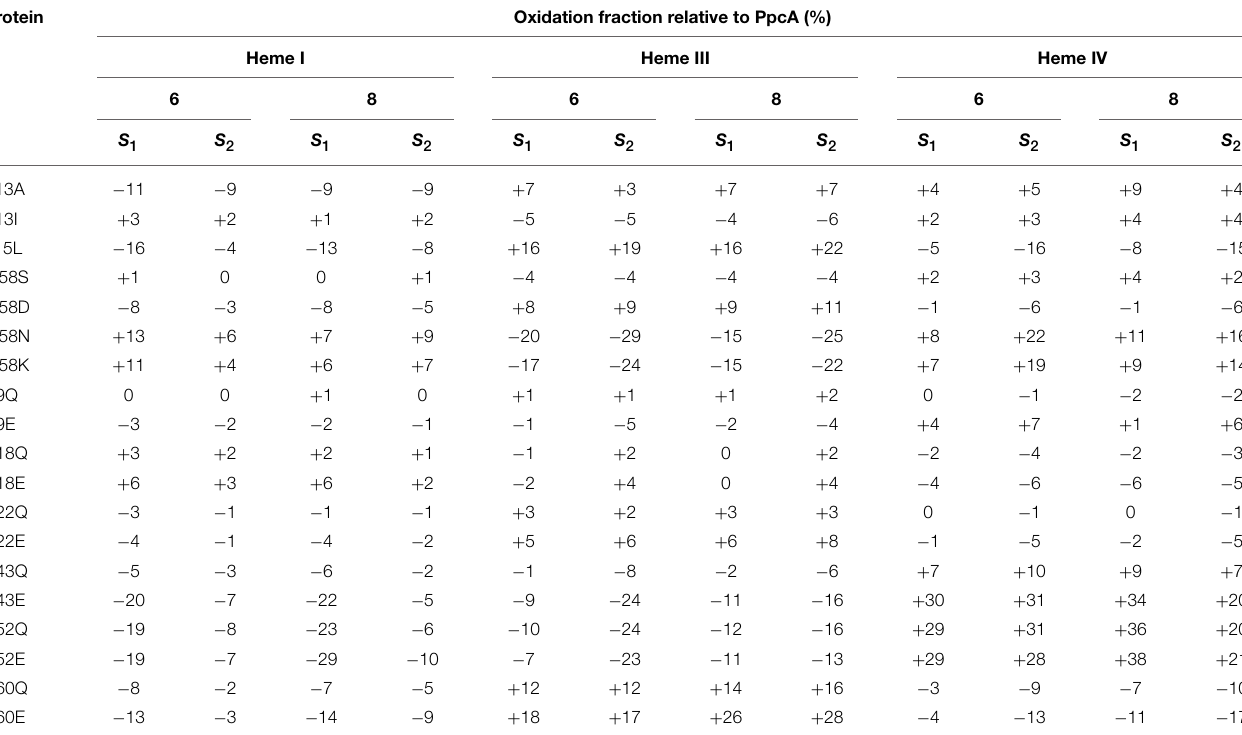
TABLE 3 | Variation of heme oxidation fractions of PpcA mutants vs. the native cytochrome (pH 6 and 8) at intermediate oxidation stages ( S 1 and S 2 ) (Dantas et al., 2012; Morgado et al., 2013, 2014). Protein Oxidation fraction relative to PpcA (%) Heme I Heme III Heme IV 6 8 6 8 6 8 S 1 S 2 S 1 S 2 S 1 S 2 S 1 S 2 V13A V13I M58S − 4 + 2 + 3 + 4 + 2 M58D − 8 − 3 − 8 − 5 + 8 + 9 + 9 + 11 − 1 − 1 − 6 M58N + 13 + 6 + 7 + 9 + 8 + 22 + 11 + 16 M58K + 11 + 4 + 6 + 7 − 17 − 24 − 15 0 + 1 0 + 1 + 1 + 2